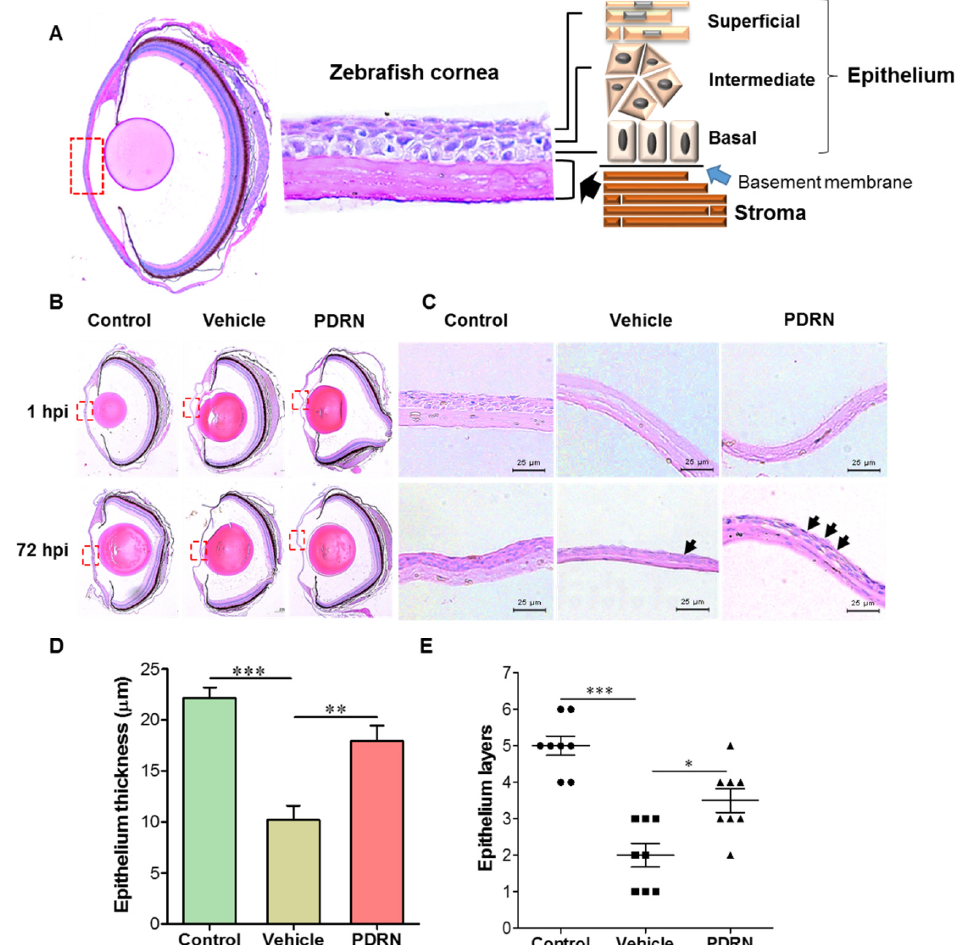
Figure 3. Histological analysis of zebrafish eye and corneal re-epithelialization following the corneal injury and PDRN treatment. ( A ) Representative image of H&E stained zebrafish eye, cornea, and graphical illustration of the corneal epithelium. ( B ) Representative photograph of the whole eye of un-injured (negative control), cornea-injured vehicle, and cornea-injured PDRN-treated groups (scale bars, 40 µ m), and ( C ) photographs of selected central epithelium surface of the cornea (scale bars, 200 µ m.) at 1 and 72 hpi. Regenerated epithelial cell layers were marked with black arrows. Quantifi- cation of corneal regeneration based on ( D ) epithelium thickness, and ( E ) number of epithelium cell layers at 72 hpi. One-way ANOVA was performed to determine the statistical significance; * p < 0.05, ** p < 0.01, *** p < 0.001 ( n =